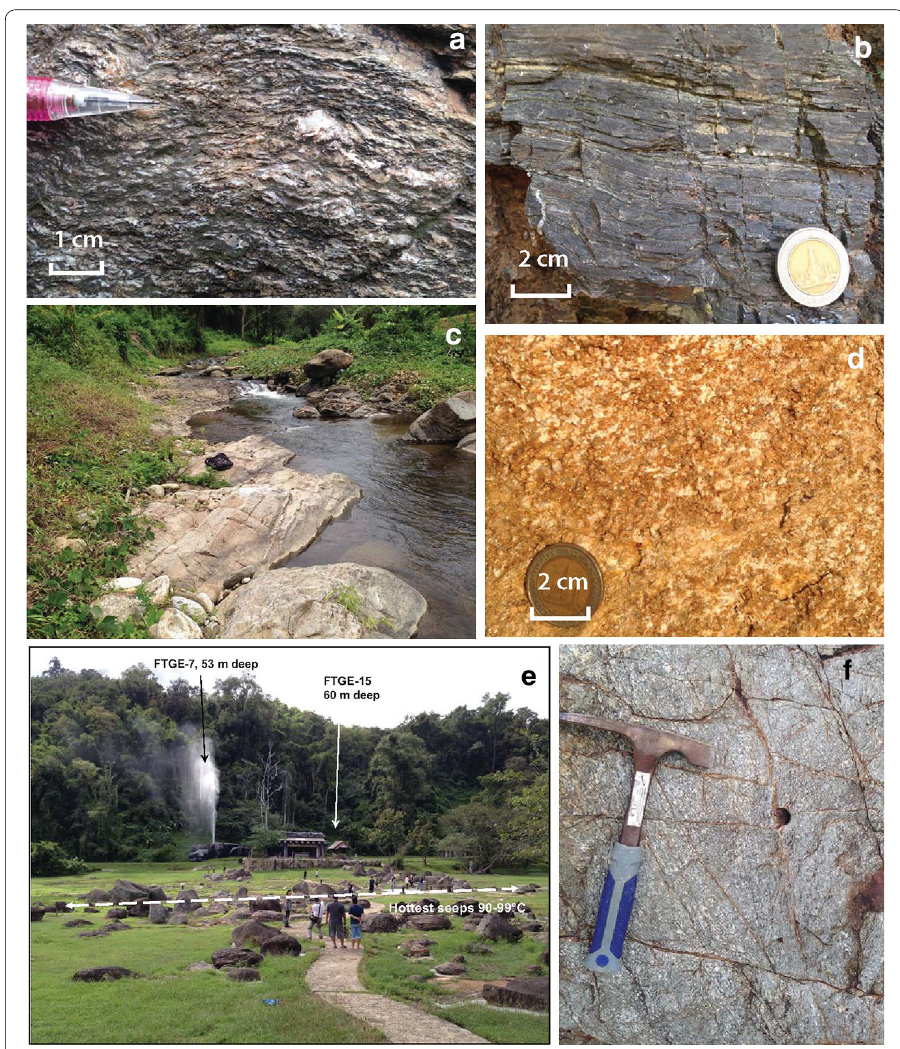
Fig. 15 Photos of gneiss and mylonite: a foliated granite with sheared porphyroclasts at the hydroelectric plant bridge (516237E, 2208078N) (pencil diameter is 9 mm). b ultra-fine-grained mylonite on the west side of Huai Hian (creek) (0518528E, 2208928N) showing foliation striking 108° and dipping 11°SW (coin diameter is 25 mm). c photo showing foliated (178°strike, 28° W dip) mylonite, with quartz veins showing strike- parallel lineation at bridge (516449E, 2207718N). d coarse grained, weakly foliated biotite granite (weathered to brown color) in cut on road to Haui Born Cave (519819E, 2209366N). e photo looking west at the hot springs area and steam plume from the FTGE-7 well. Hot springs area is studded with corestones of foliated granite. f photo showing fractures in foliated granite filled with brownish veinlets of chalcedony (?) (515300E,